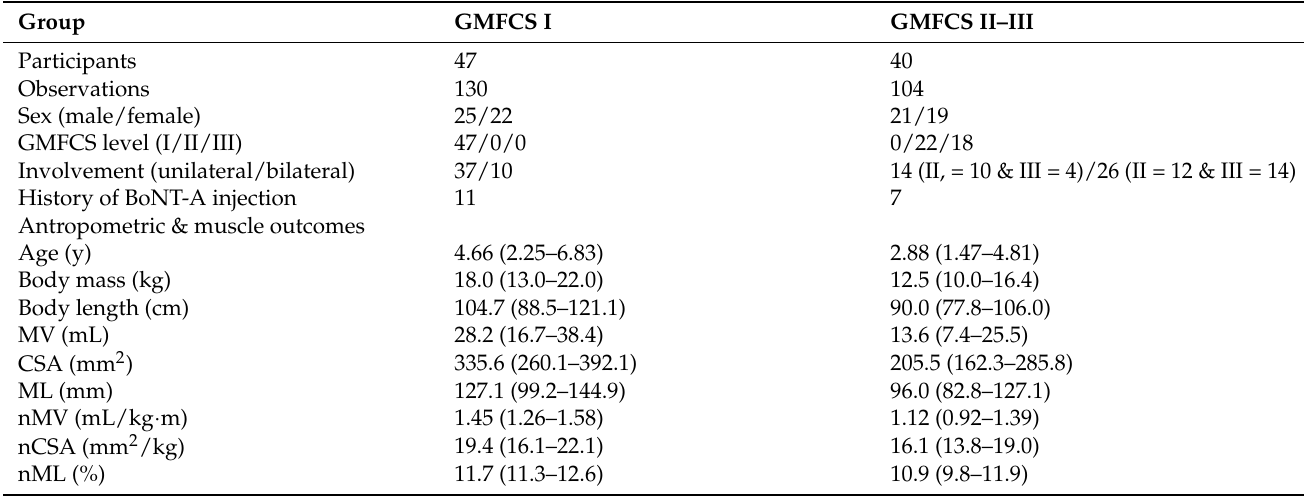
Table 1. Participant characteristics of the children with SCP at baseline